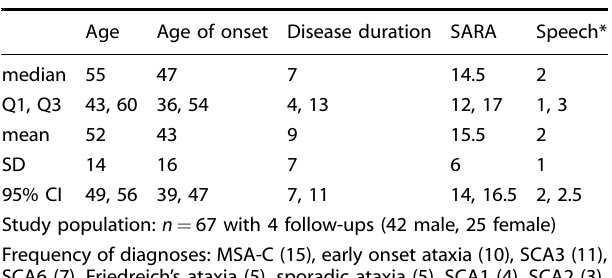
Table 1. Patient characteristics.